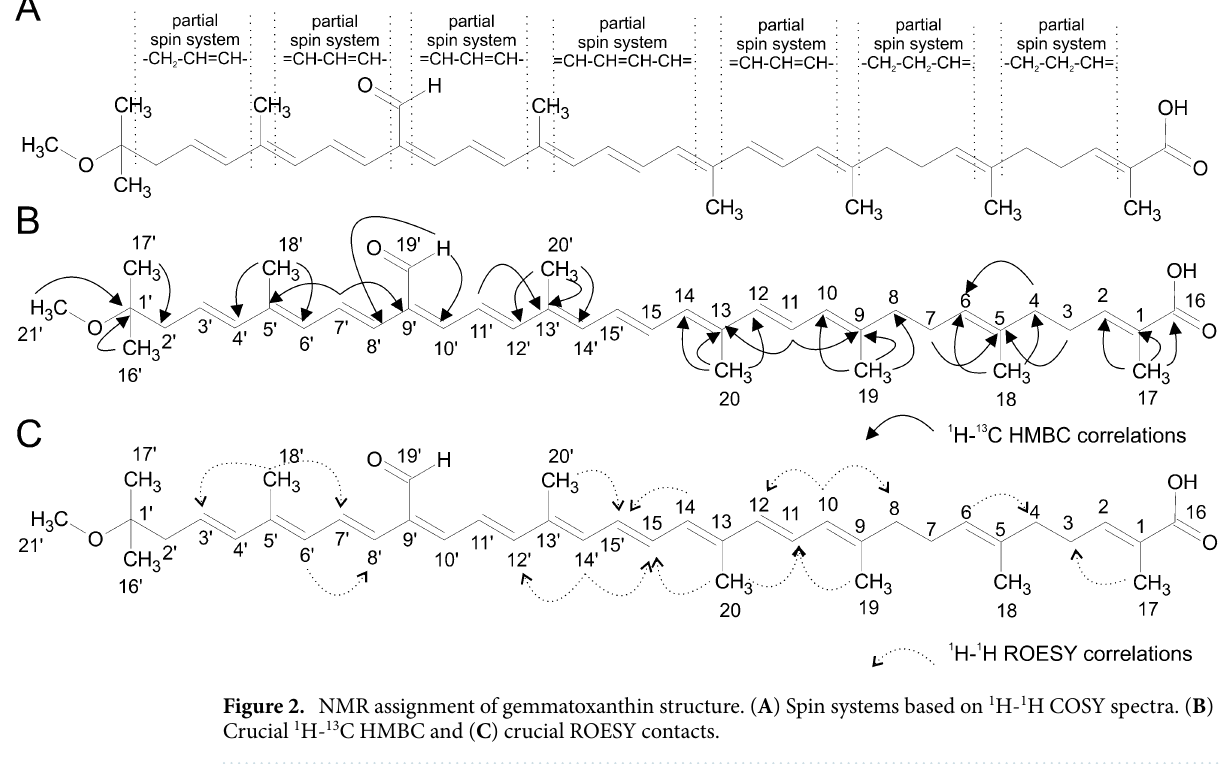
Figure 2. NMR assignment of gemmatoxanthin structure. ( A ) Spin systems based on 1 H- 1 H COSY spectra. ( B ) Crucial 1 H- 13 C HMBC and ( C ) crucial ROESY contacts.